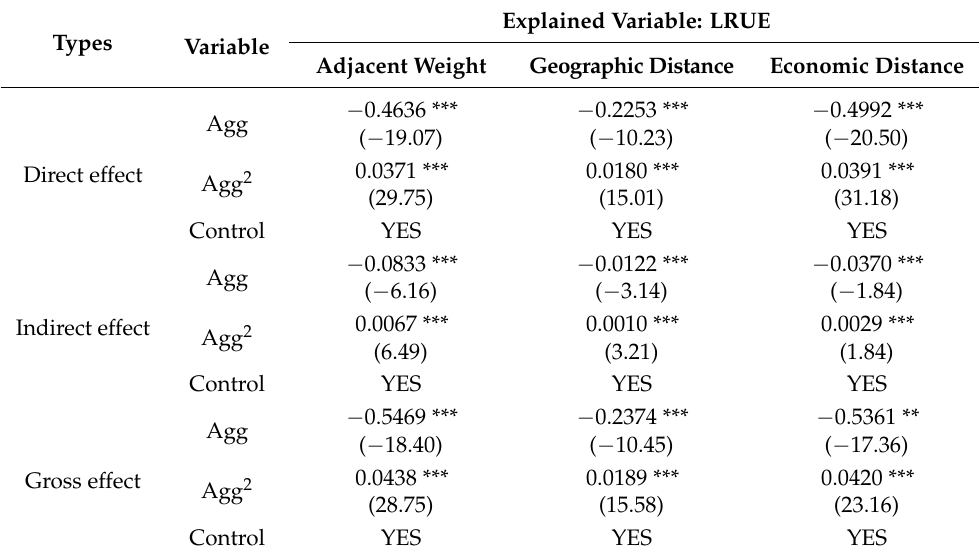
Table 5. Results of the effect decomposition of the spatial econometric model.